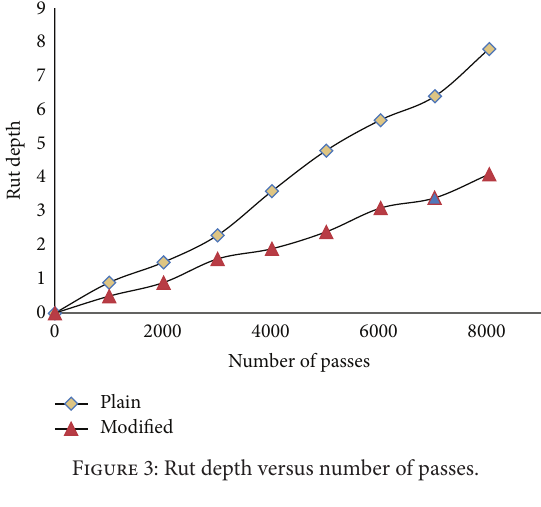
Figure 3: Rut depth versus number of passes.